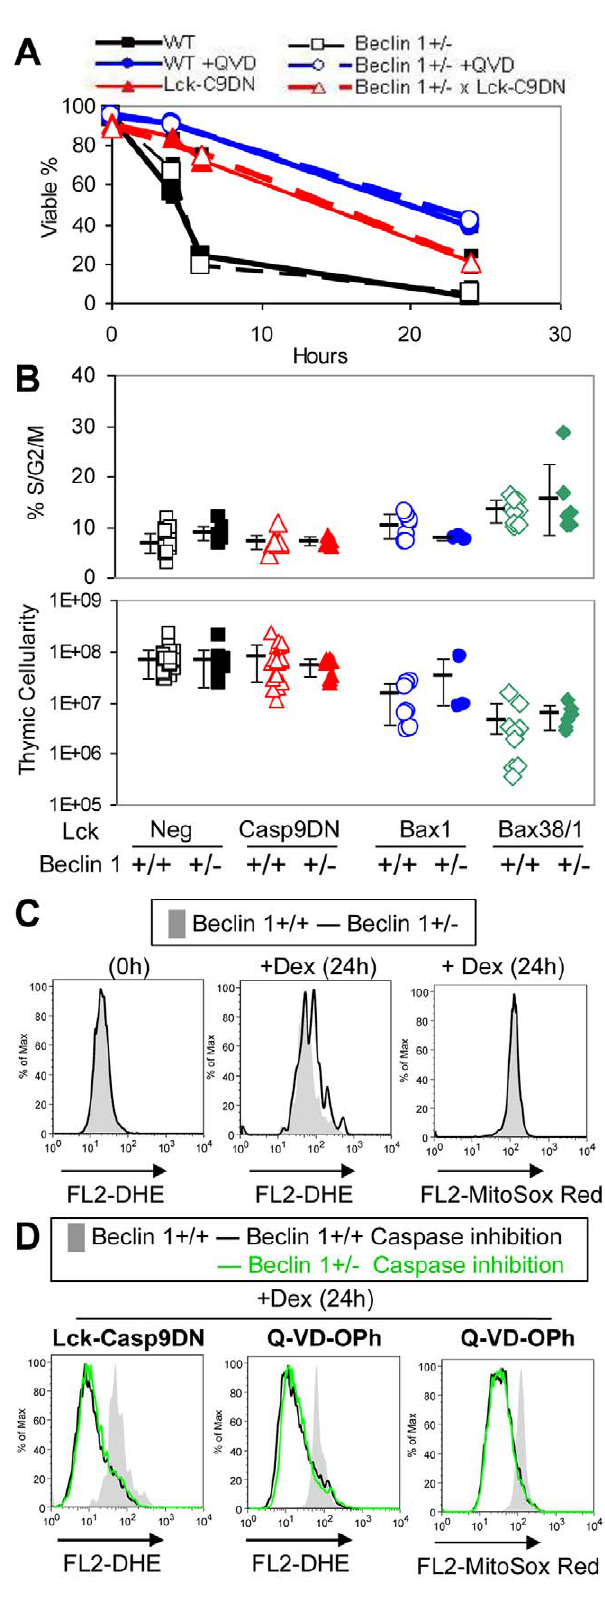
Figure 7. Beclin 1 + / 2 has no effect on cell death, proliferation and ROS levels in thymocytes. A ) Isolated thymocytes from mice of the indicated genotypes were treated with Dex (1 m M), using Q-VD-OPh (50 m M) as positive control for Caspase inhibition. Viability was